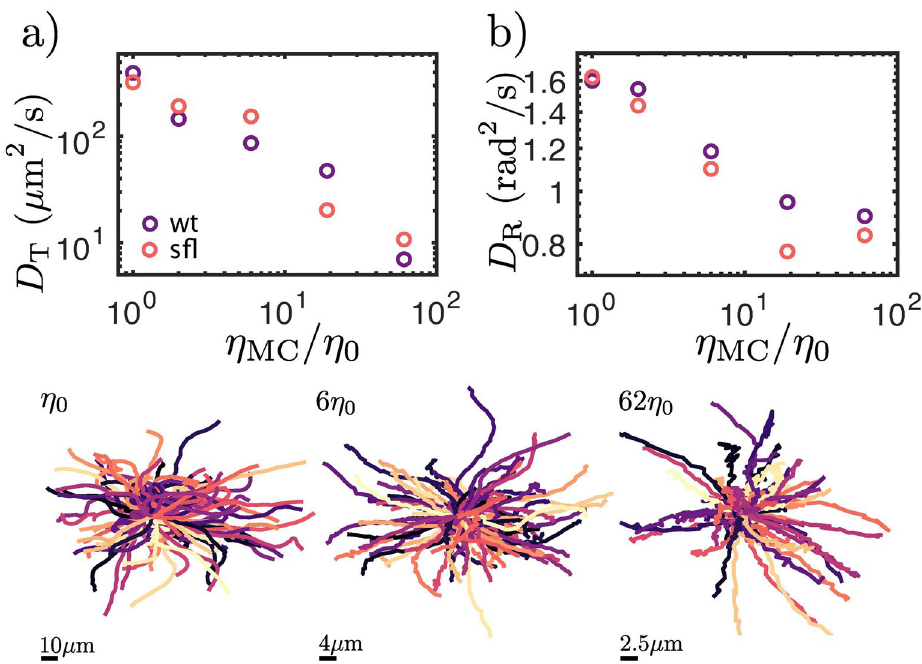
Figure 3. Top row: translational and rotational diffusion coefficients for wt and sfl CR as a function of the viscosity of the surrounding medium. Bottom row: typical 3s trajectories for CR swimming in different viscosity media. Figure panels were arranged and labels were added using the proprietary software Affinity Designer 1.8 (https ://affin ity.serif .com/en-gb/desig ner/).